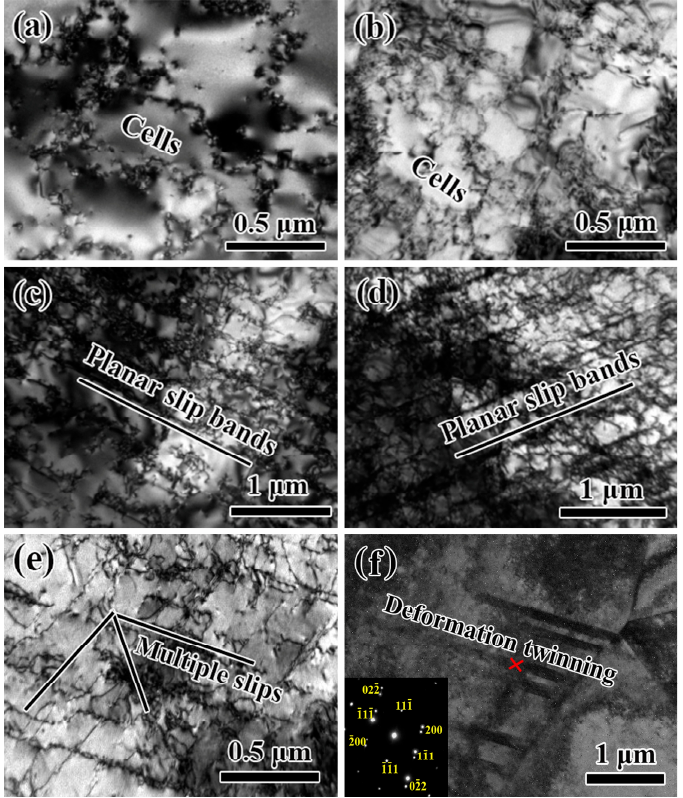
Figure 8. TEM images showing the deformation microstructures after 7% cold rolling: ( a , b ) Ni-5at.%Cr; ( c , d ) Ni-20at.%Cr; ( e , f ) Ni-40at.%Cr.